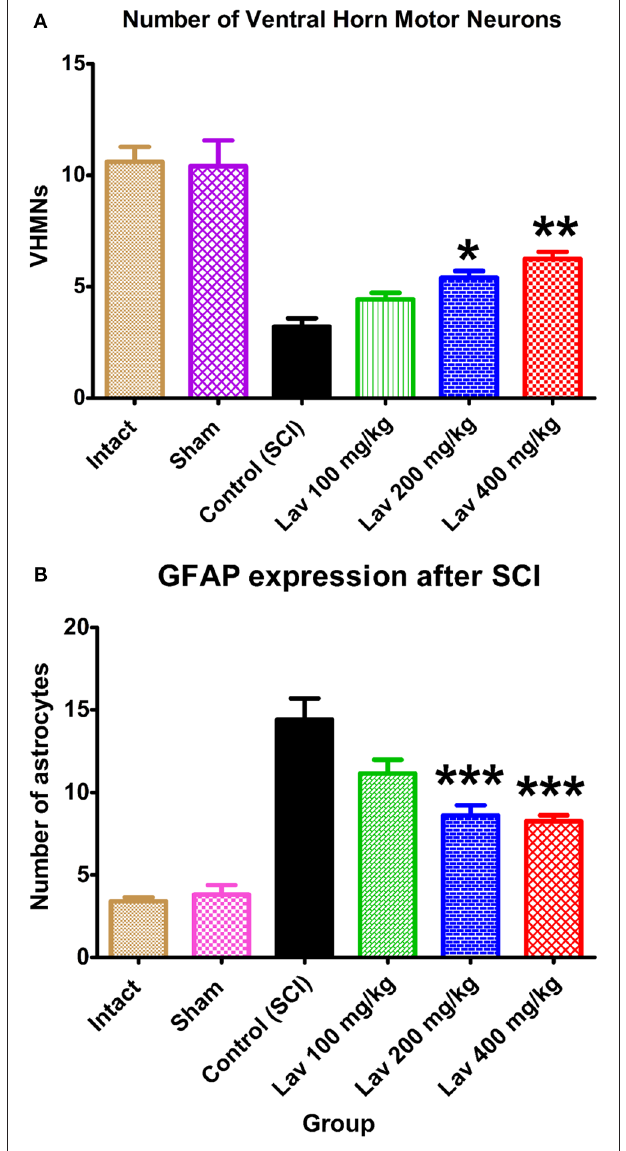
FIGURE 3 | Administration of L. angustifolia increased the number of VHMNs (A) and decreased GFAP expression in the rat spinal cord contusion model. Intraperitoneal administration of L. angustifolia extract daily for 14 consecutive days post-injury significantly increased the number of VHMNs (A) and decreased the levels of GFAP expression in the rat spinal cord contusion model (B) . Data are represented as mean ± SEM. (A) * and ** show significant differences of the Lav 200 and Lav 400 groups with the control (SCI) group ( P < 0.05 and P < 0.01 , respectively). (Per 5700 µ m 2 ). (B) *** shows significant differences of the Lav 200 and Lav 400 groups with the control (SCI) group ( P < 0.001 ). (Per 35625 µ m 2